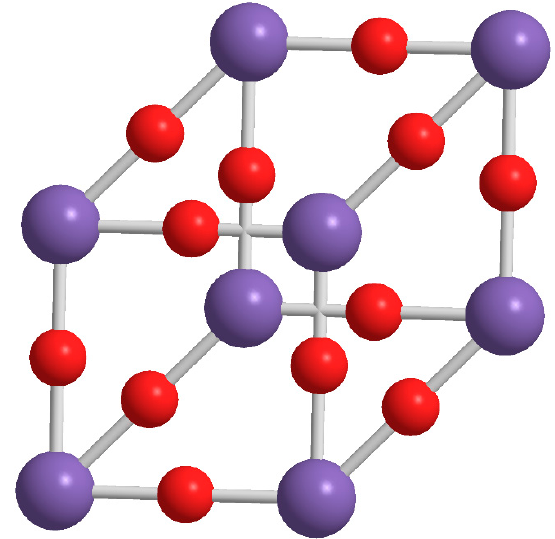
Figure 1. Molecular structure of single-cage POSS molecule.